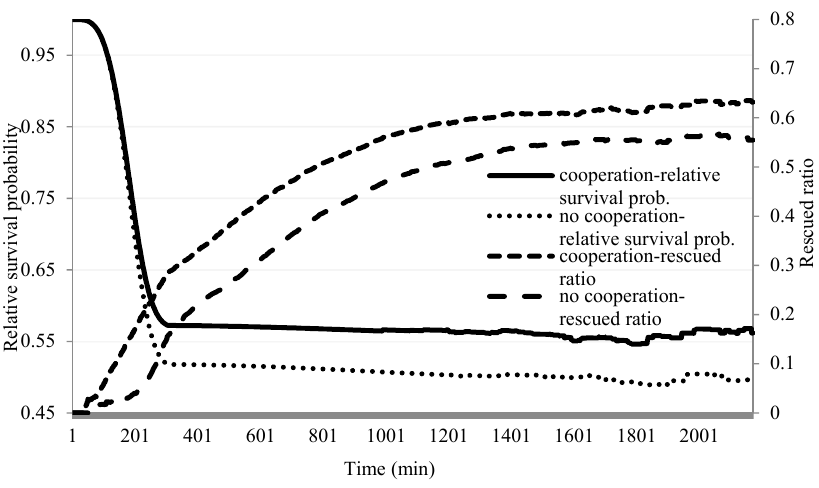
Figure 5. The average output results of 200 runs at every step in scenario “Fatal”.